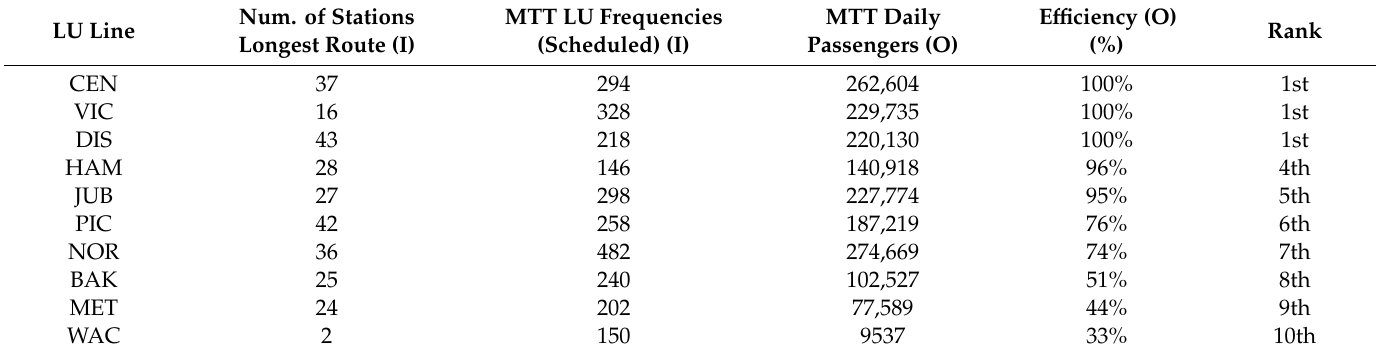
Table 12. URT lines DEA model scores of LU Monday to Thursday (MTT) Midday tra ffi c.